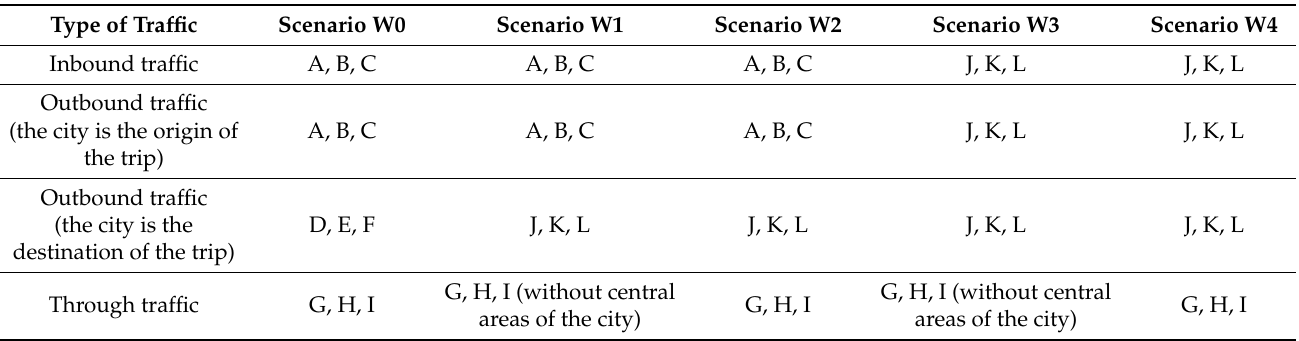
Table 4. The fleet compositions in the transport model adopted for the reference scenario W0 and for the scenarios W1–W4 for the purposes of analyses of exhaust